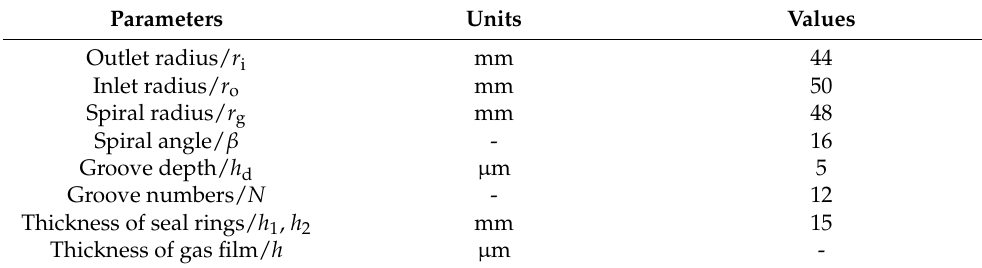
Figure 1. The three-phase diagram of helium and the geometrical diagram of a spiral-grooved face seal. Table 1. Relevant geometrical parameters of the spiral-grooved face seal.